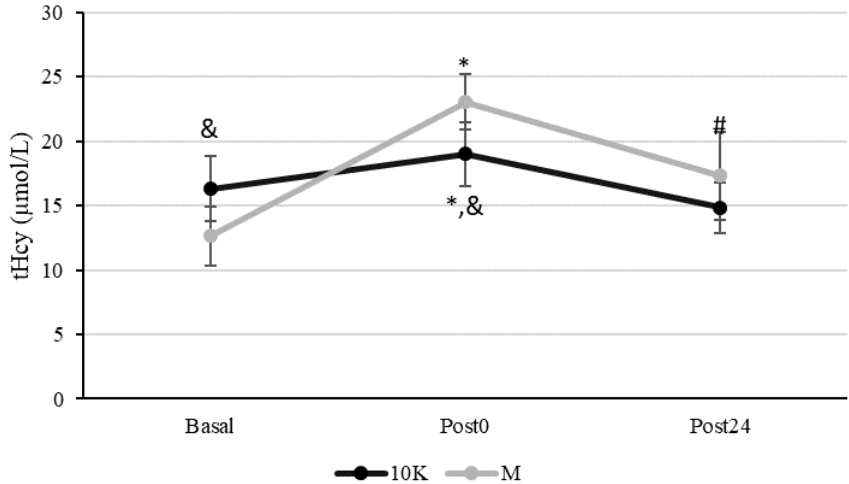
Figure 1. Kinetics of plasma homocysteine concentration (tHcy, µ mol/L) in response to a 10 km race (10K, black line) and a marathon (M, grey line). Basal: sample collected within 1 h before each race; Post0: sample collected within 10 min after the race; Post24: sample collected 24 h after Basal. * Significantly different ( p < 0.05) from Basal and Post24; # Significantly different ( p < 0.05) from Basal. & Significantly different ( p < 0.05) from Marathon (M). Data are presented as mean ± standard deviation. Sample size, N = 9.